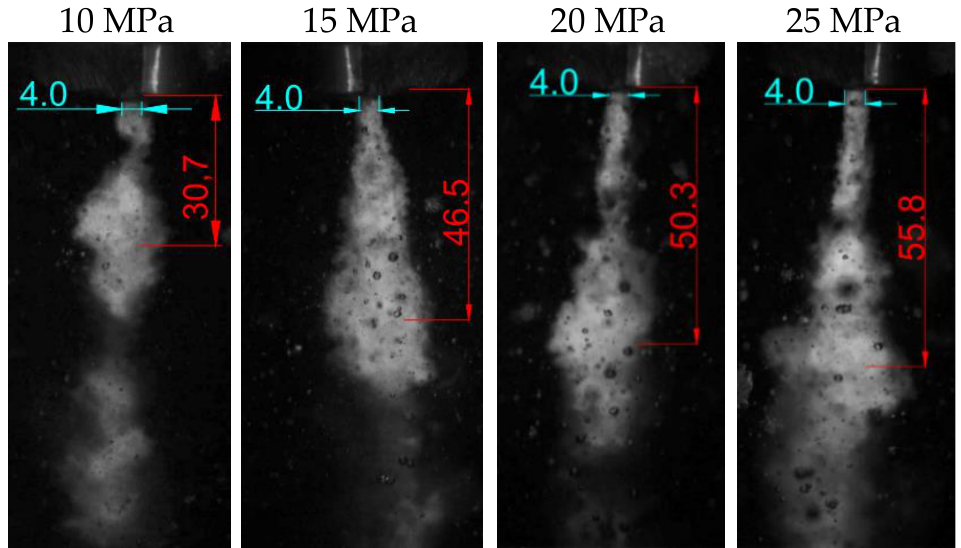
Figure 16. Examples of images of shaping hydrodynamic pulses produced in an aquatic environment. The average distances of the hydrodynamic pulses from the outlet nozzle of the tested pulse head are presented in Figure Table 7. Measurements of the distance between the shaping of hydrodynamic impulses in the wa- ter stream flowing from the outlet nozzle of the head intended for drilling holes, working in the water environment.